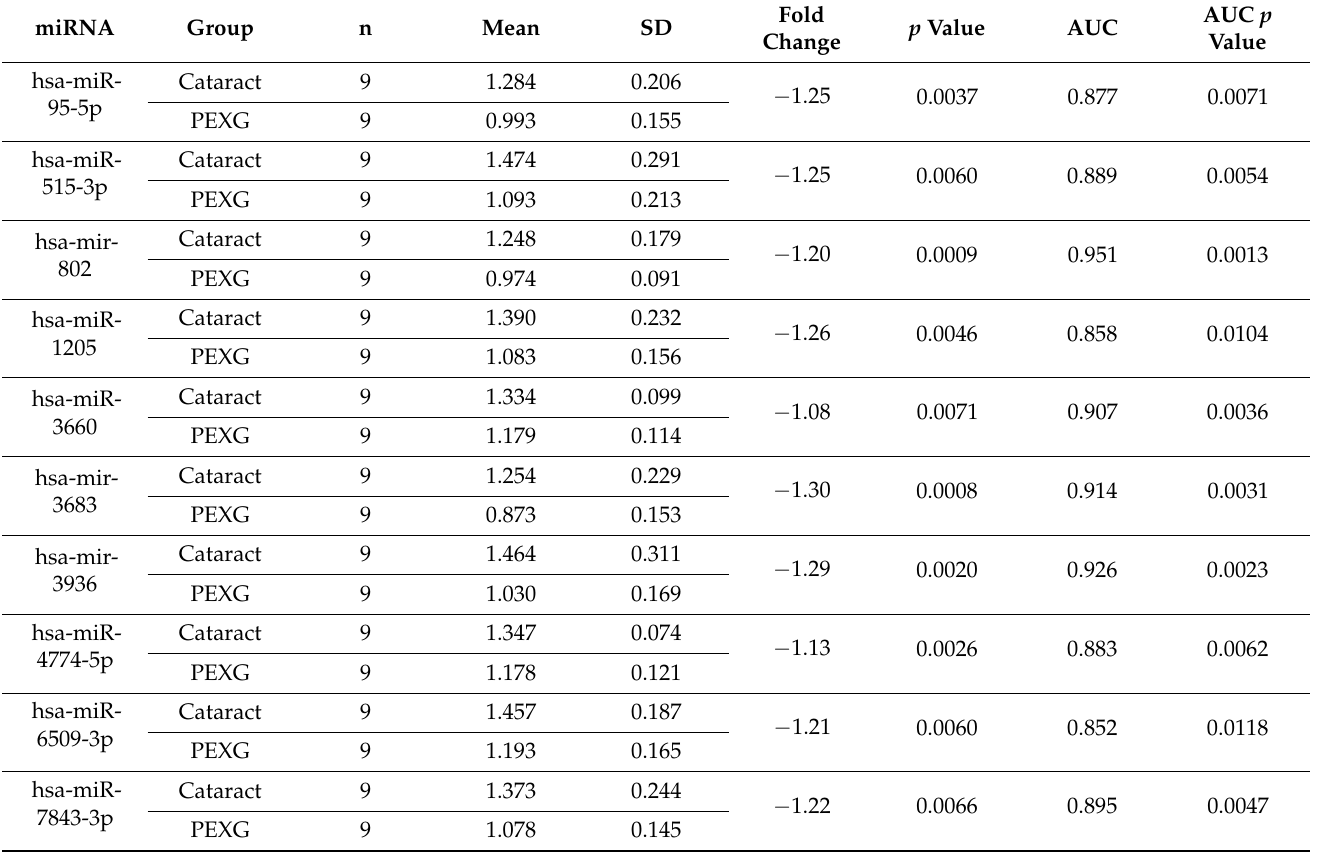
Table 2. 10 miRNA downregulated in the PEXG group compared to the cataract group [log2].